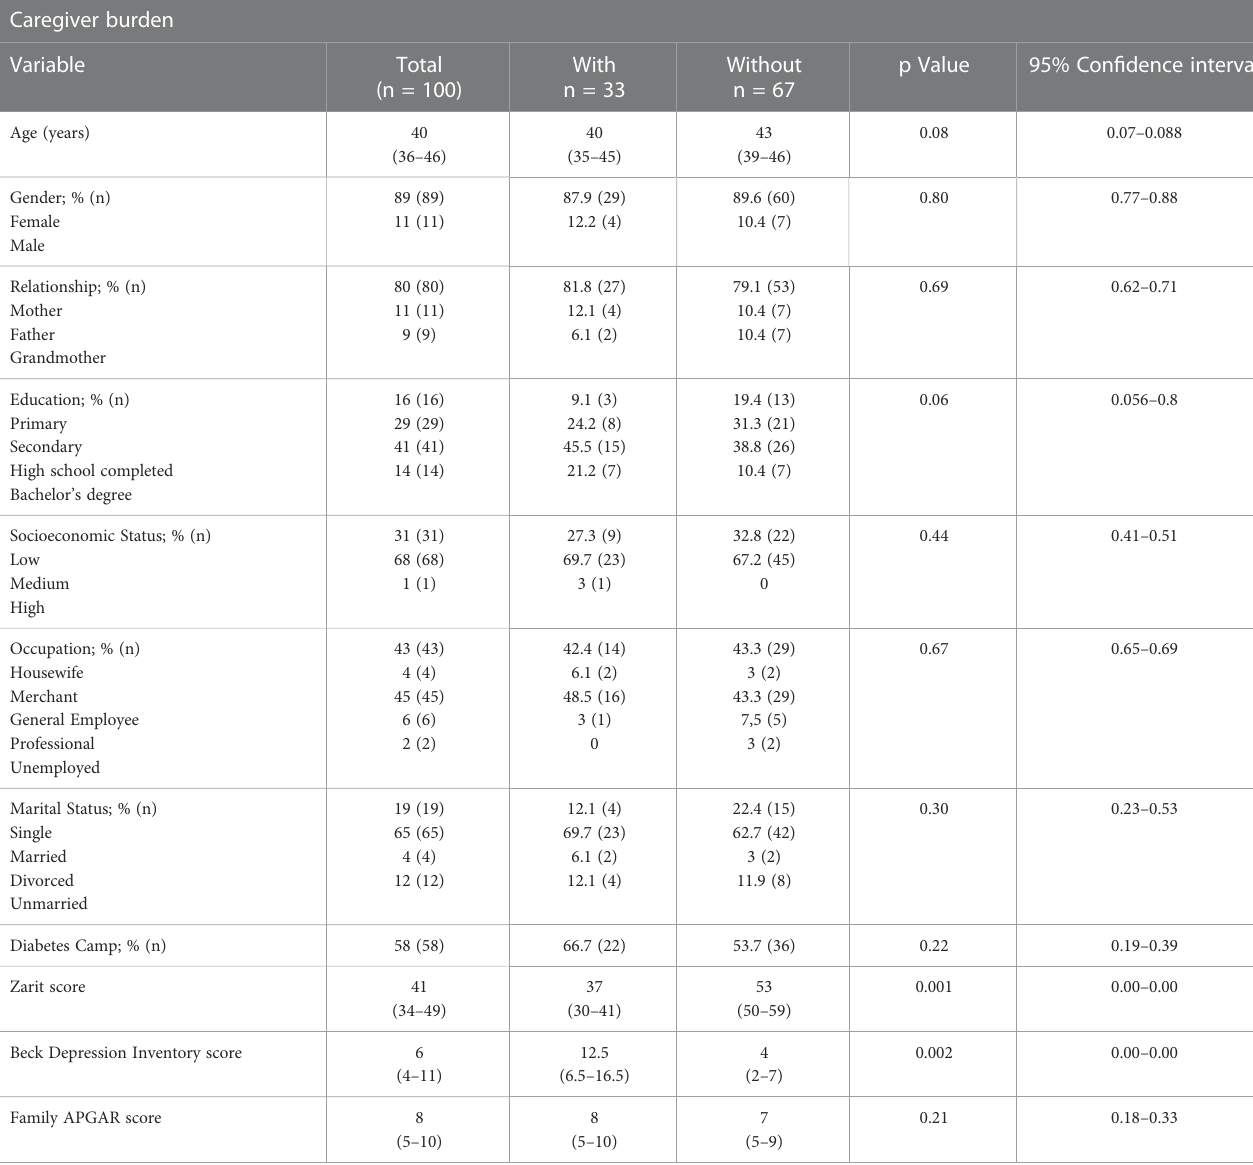
TABLE 2 Characteristics of primary informal caregivers and differences according to the presence of caregiver burden. Caregiver